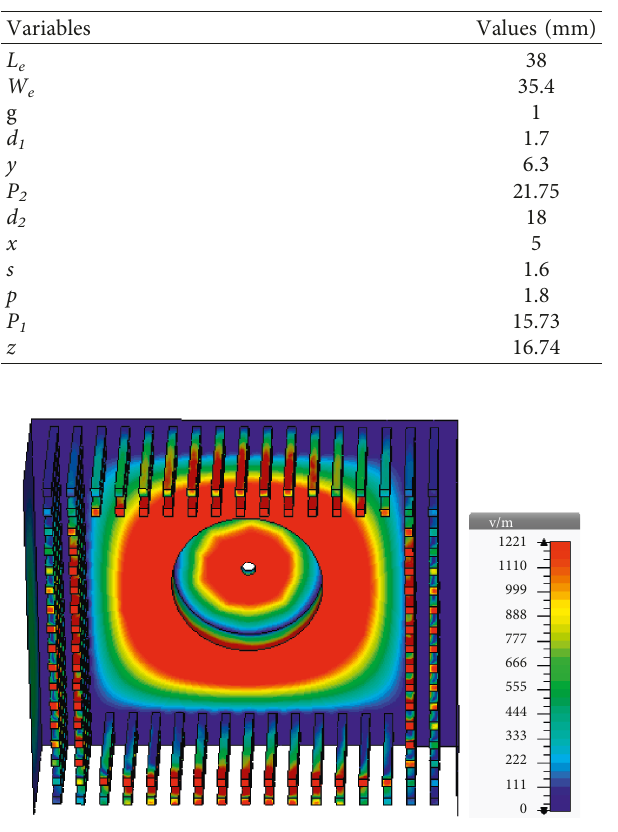
Figure 5: Predicated electric field (v/m) of the suggested sensor at 6.1GHz.